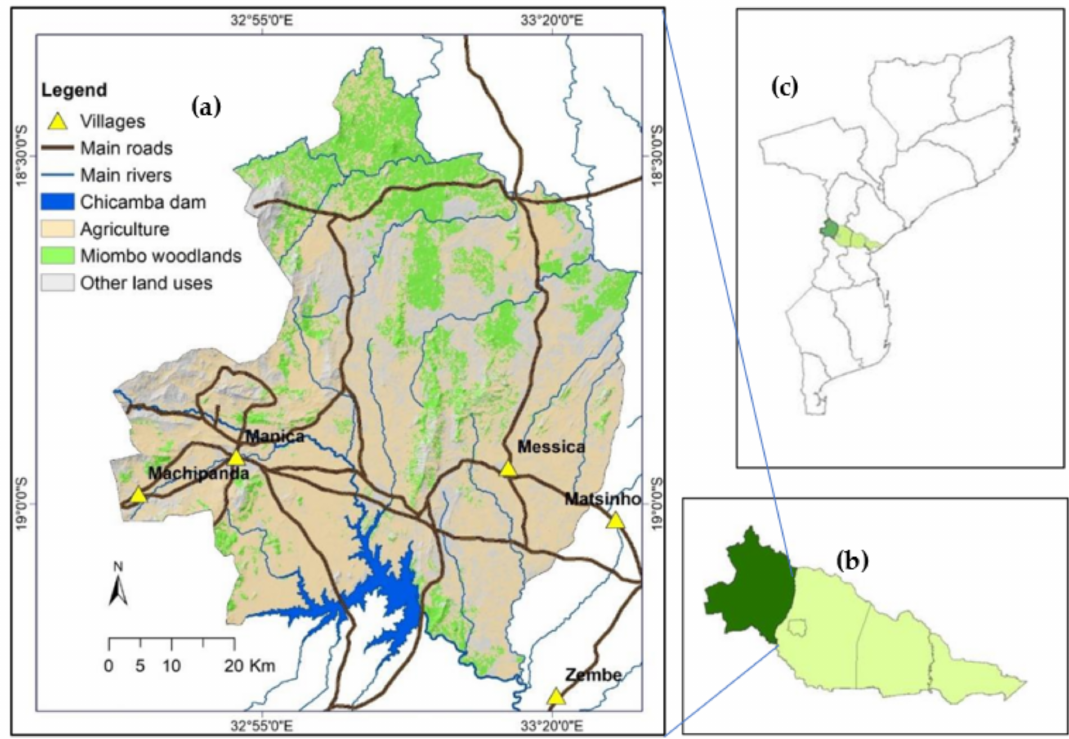
Figure 1. Location of the study area ( a ) within the Beira Corridor ( b ); the centre part of the country ( c ). Land use and land cover data source: Government of Mozambique